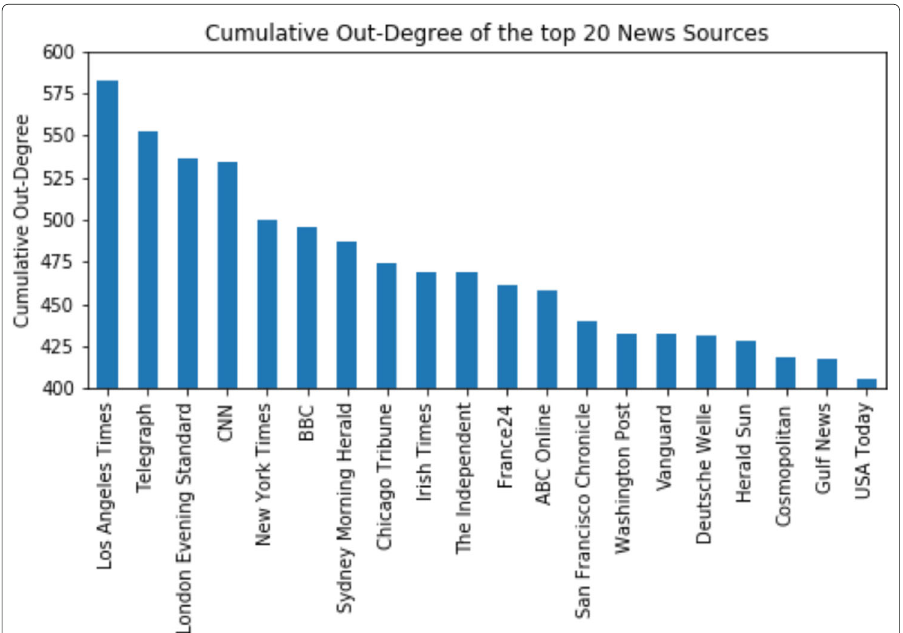
Fig. 6 The cumulative out degree of the top 20